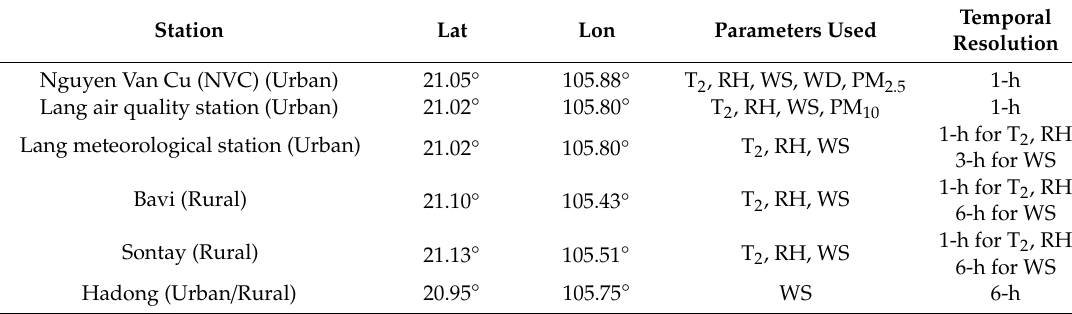
Table 1. List of air quality and meteorological